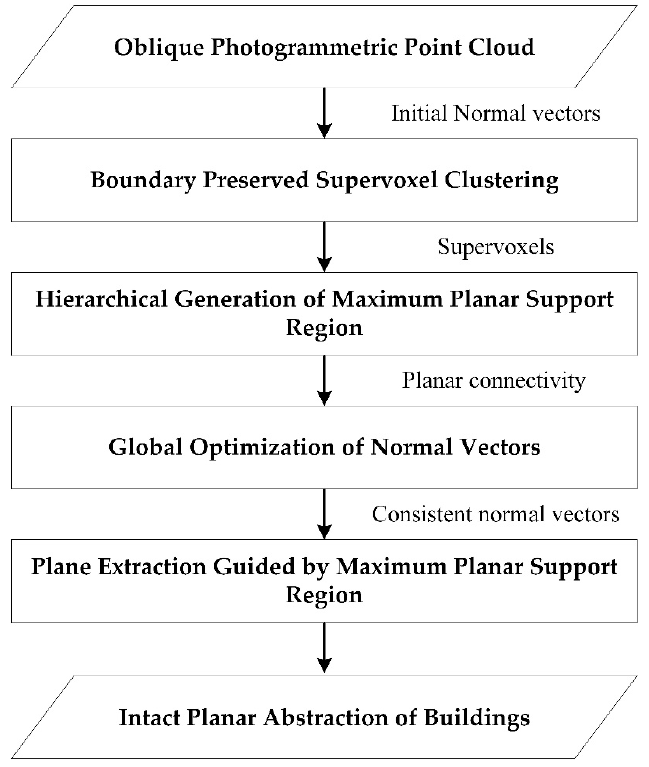
Figure 2. Processing pipeline of the proposed method.